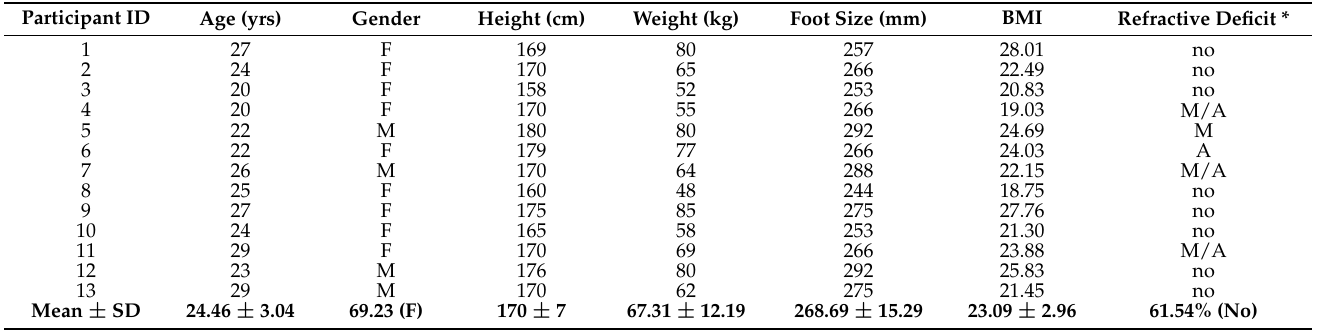
Table 1. Demographic characteristics of the study sample. Abbreviation: SD: standard deviation; F: Female; M: Male; BMI: Body Mass Index; M: Myopia; A: Astigmatism. * Correction with glass or contact lenses.